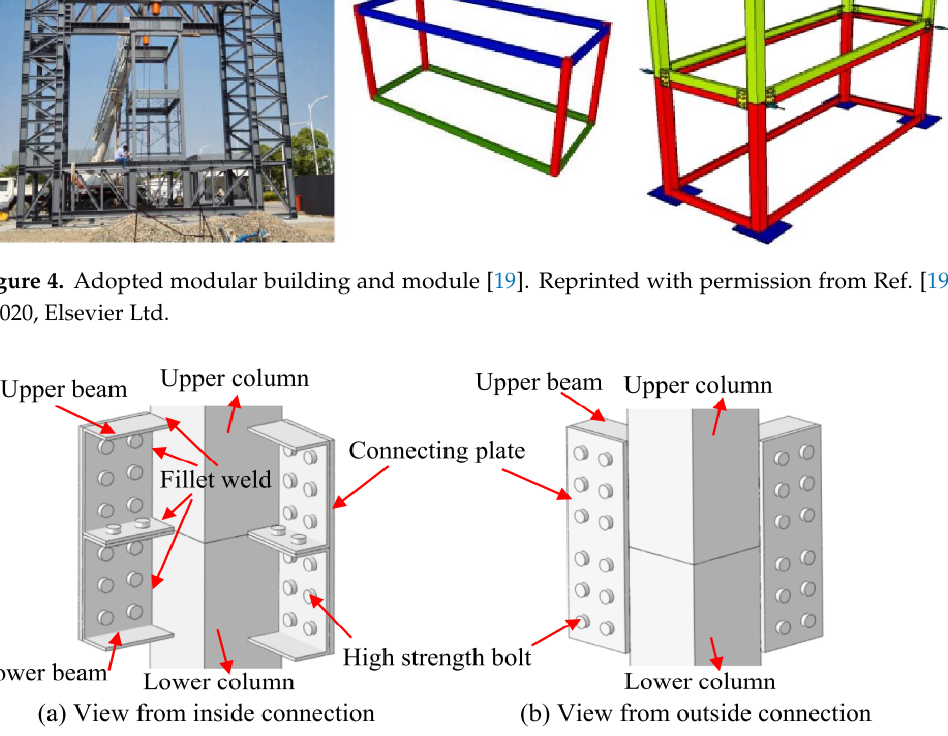
Figure 5. The splice connections [20]. Reprinted with permission from Ref. [20] © 2021, Elsevier Ltd.